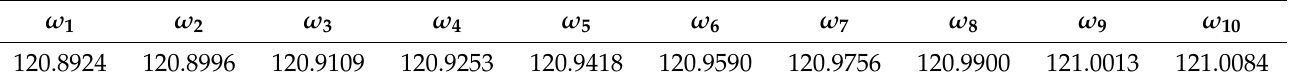
Table 1. Natural eigenfrequencies of the 10-beams system in Hz . ω